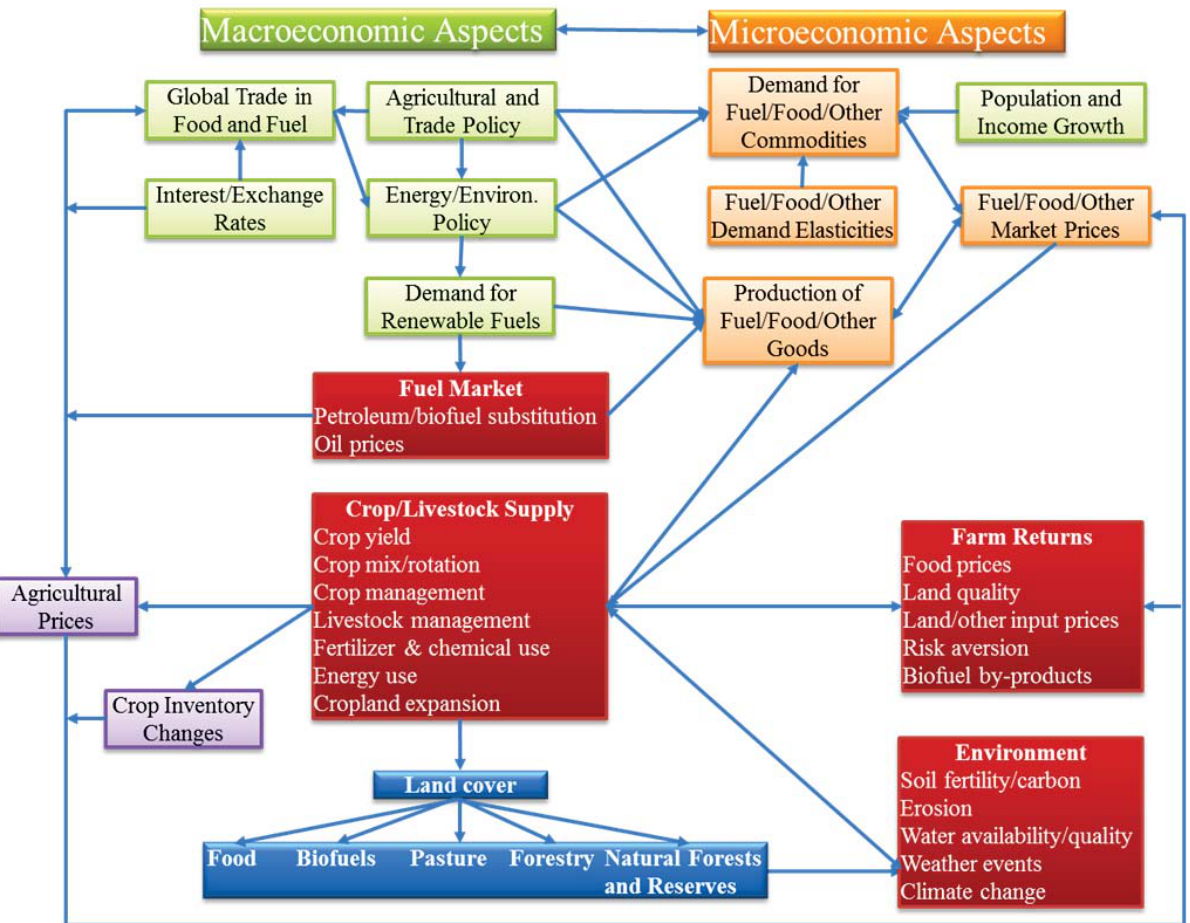
Figure 2. A framework for analyzing biofuel-food market interactions (adapted from Figure 4 of Rathman et al .